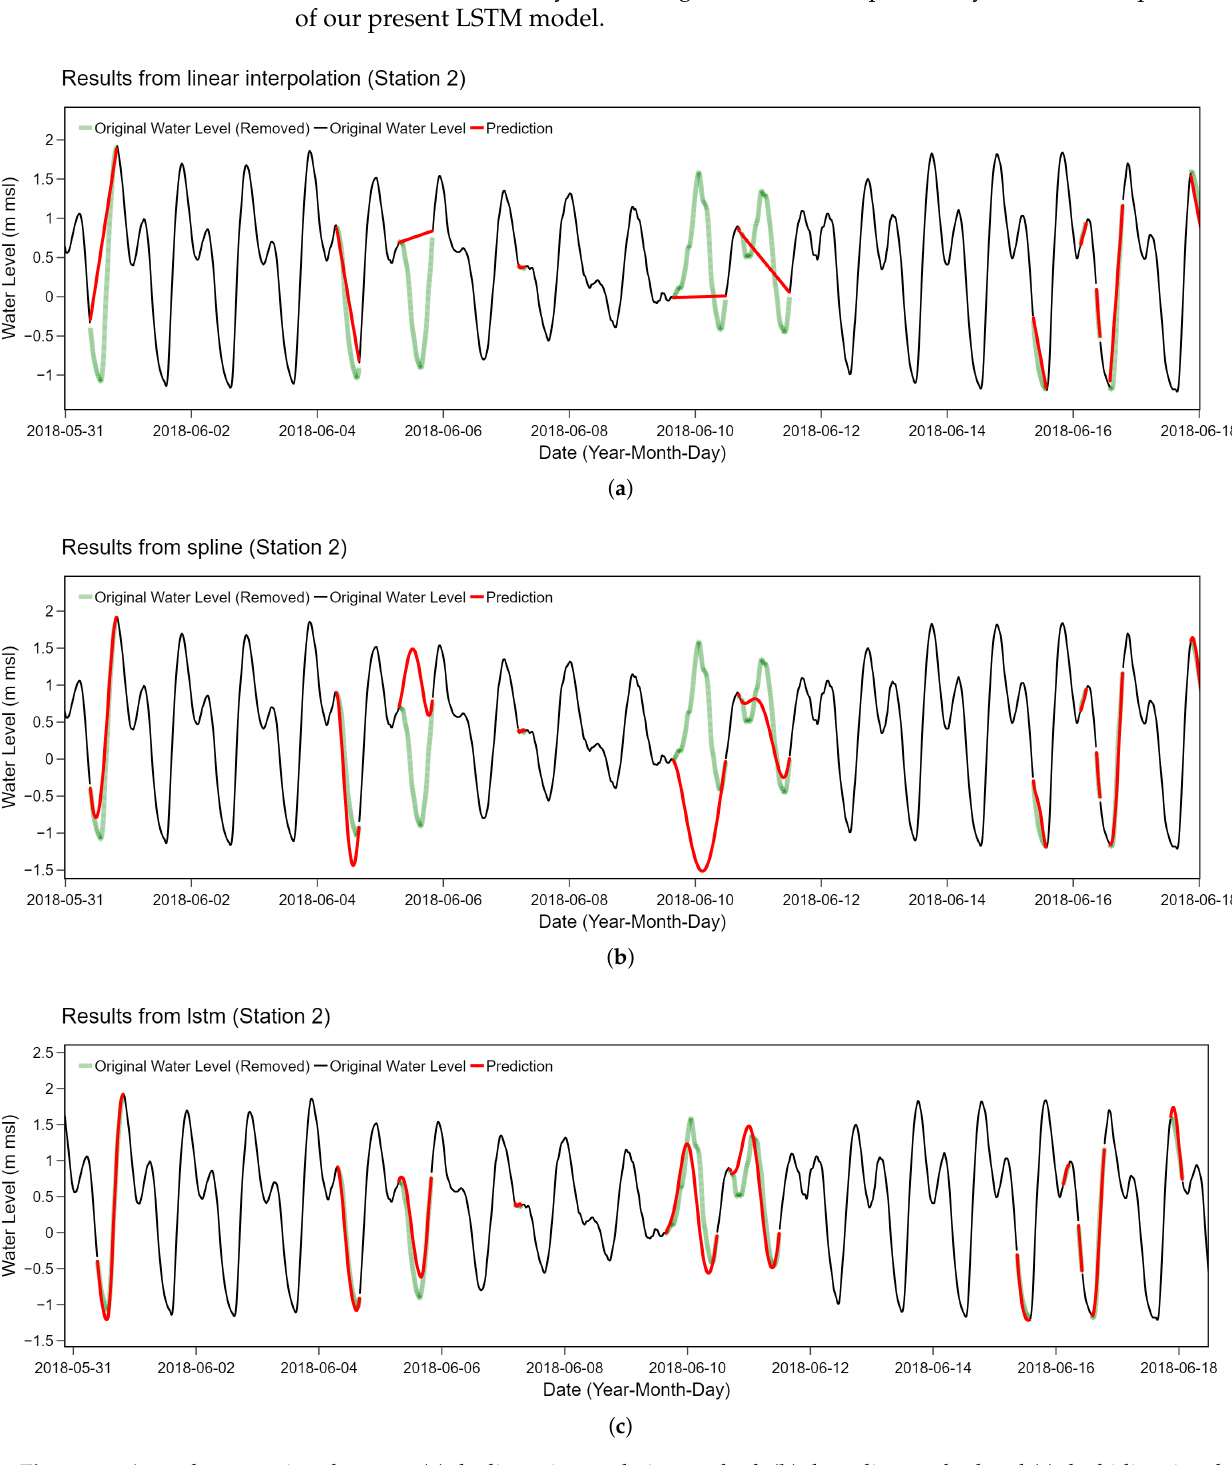
Figure 12. A result comparison between ( a ) the linear interpolation method, ( b ) the spline method and ( c ) the bidirectional LSTM method for station